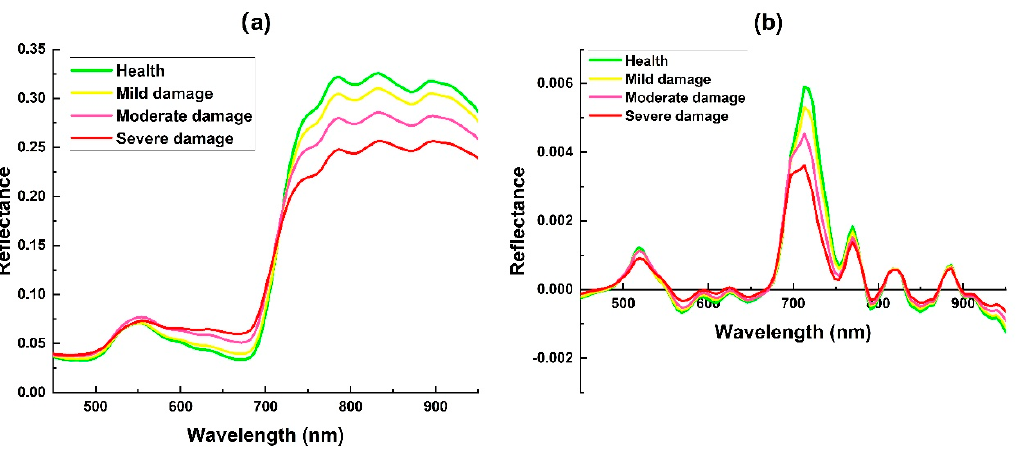
Figure 10. Spectral characteristics of damage degree in Pinus yunnanensis by Tomicus (Needle) ( a ) Spectral reflectance of Pinus yunnanensis (Needle) with different damage degree; ( b ) the first derivative value of Pinus yunnanensis needles with different damage degree).